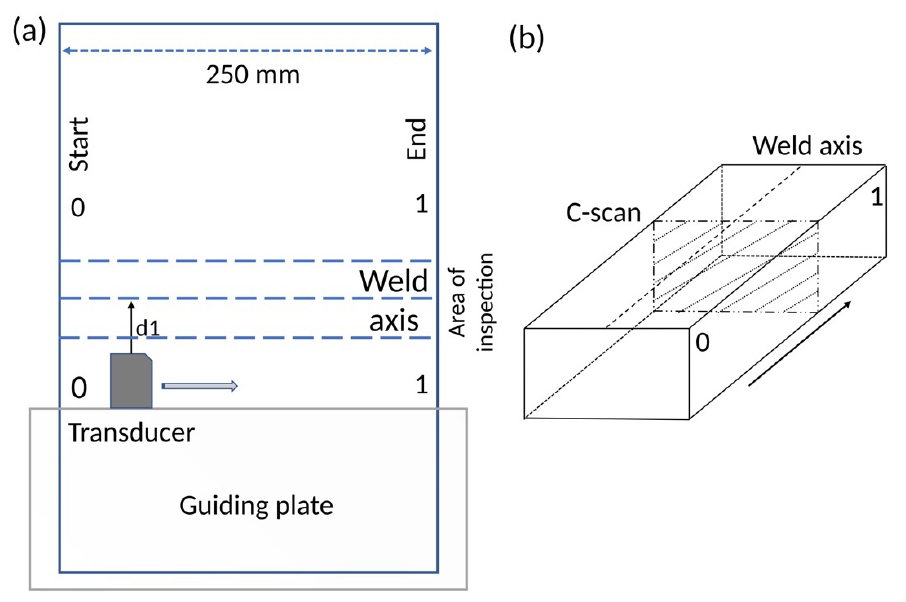
Figure 3. ( a ) Scheme of the welding inspection detailing the weld axis and the position of the transducer on the guiding plate; ( b ) Position of the C-scans and the weld axis.